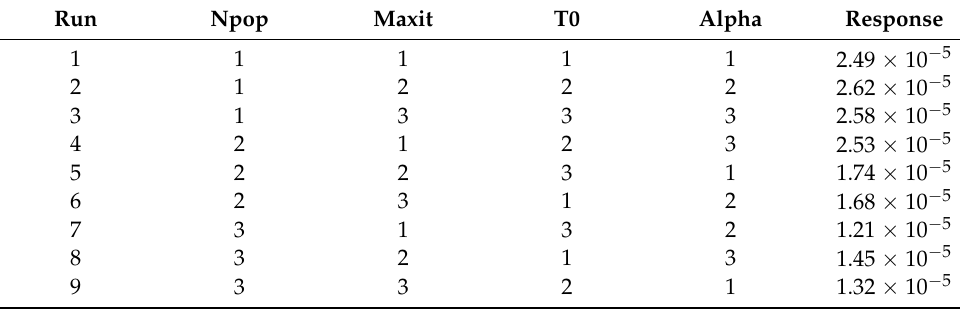
Table A6. The orthogonal array L9 and computational results for